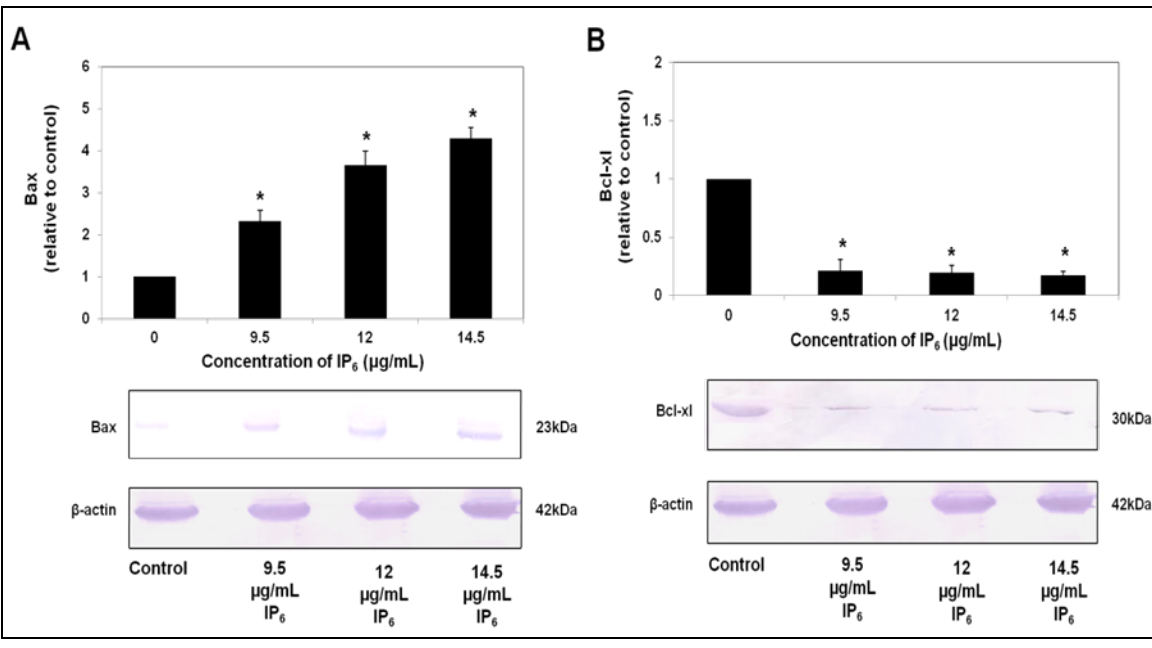
Figure 3. The effect of IP on apoptotic protein levels in HT-29 cells. ( A ) IP 6 protein expression of Bax; ( B ) IP reduced protein expression of Bcl-xl in a dose-dependent 6 manner. Results are from 3 independent experiments and presented as the mean ± SD. * indicate significant difference by Tukey’s test ( p < 0.05) relative to their respective